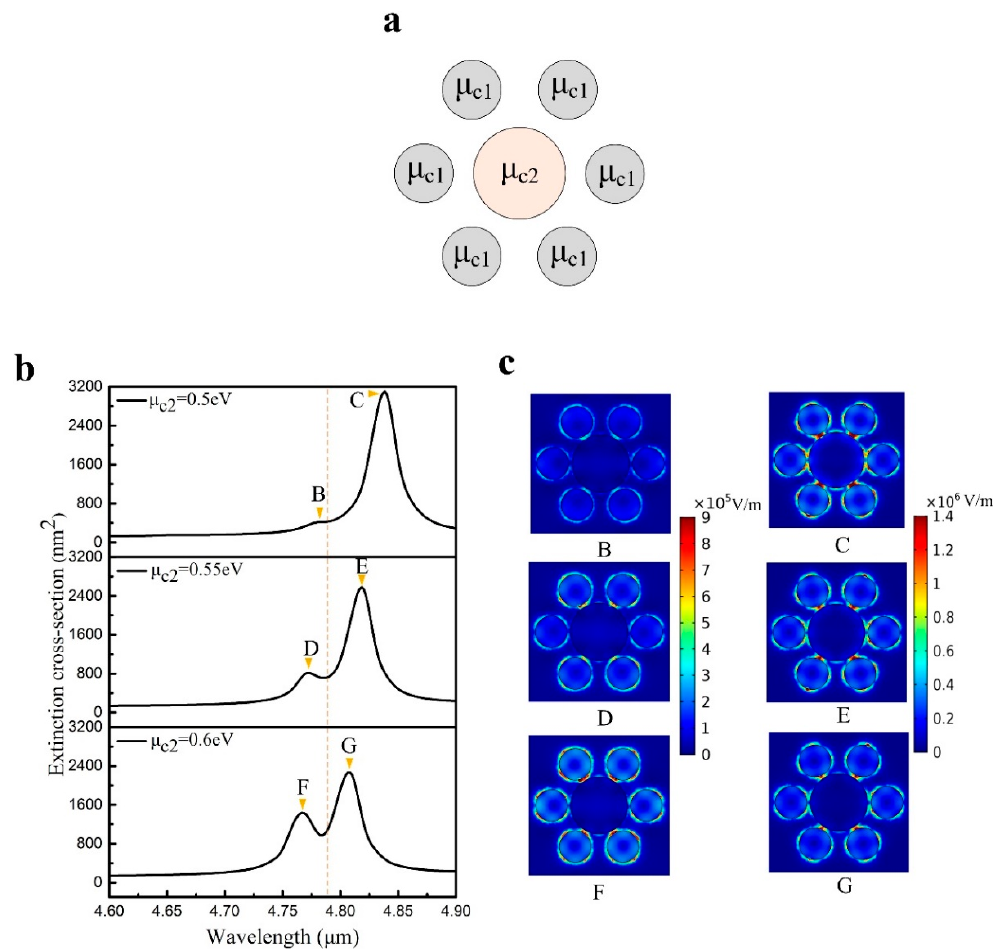
Figure 3. ( a ) Distribution of different chemical potentials in graphene heptamers. ( b ) Extinction spectra with different chemical potentials of the central nanodisk. ( c ) The electric field (|E|) distribution of plasmonic resonance peaks B to G.